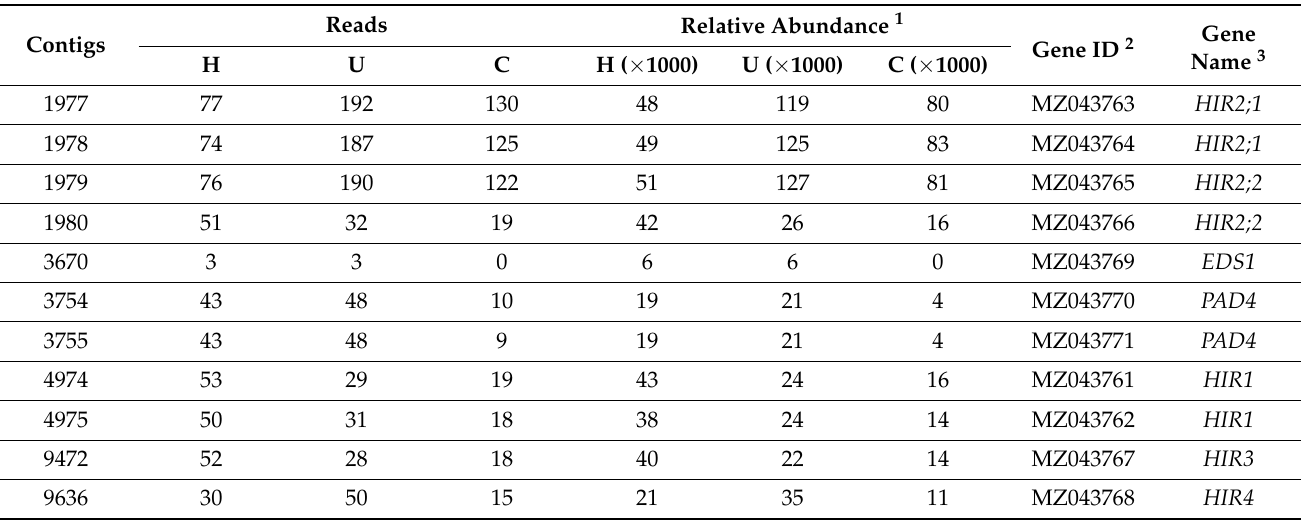
Table 1. Number of reads and relative abundance (Ra) of transcripts with homology to HIR , EDS1 and PAD4 genes. HDT transcriptome was constructed from leaves inoculated with Hemileia vastatrix (H), Uromyces vignae (U) and control leaves sprayed with water (C).